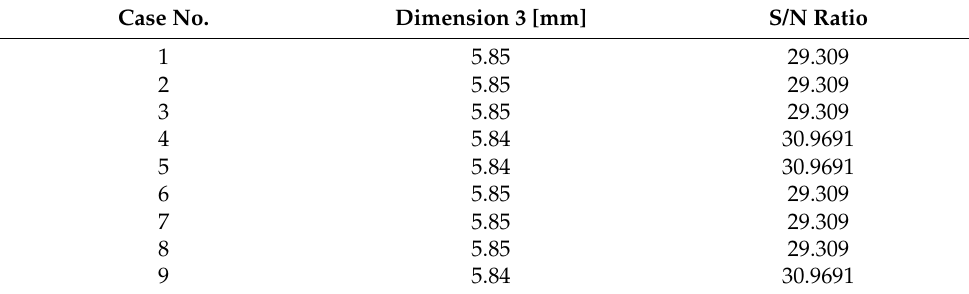
Table 19. S/N ratio of measurement 3 for open lever.